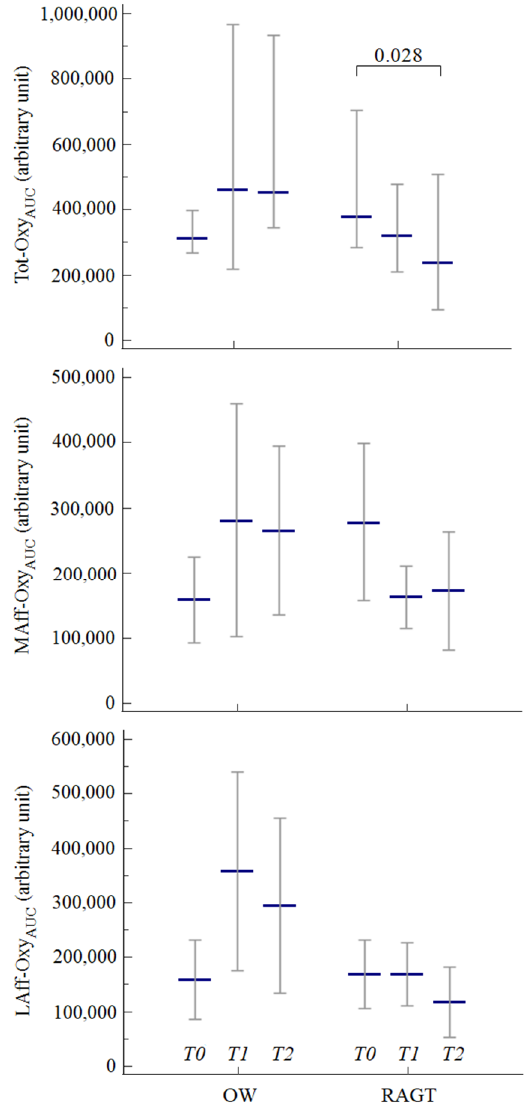
Figure 3. Variations in total and hemispheric cortical activation over time between the two groups. Legend: data are expressed as median values and respective 95% confidence intervals. Abbreviations: OW, overground walking; RAGT, robot-assisted gait training; T0, baseline; T1, after 6 sessions; T2, at the end of treatment.